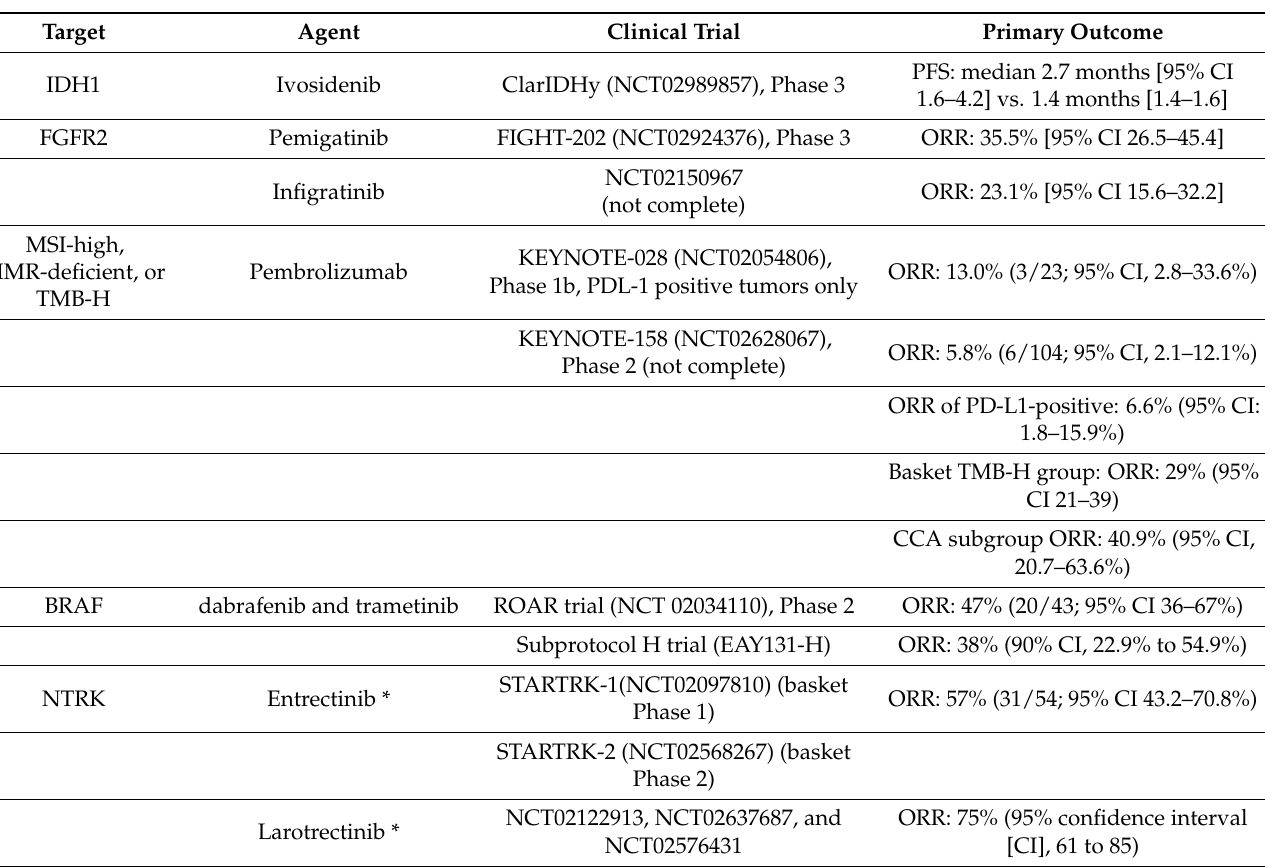
Table 1. Primary outcomes of completed clinical trials of targeted inhibition in iCCA. ORR: overall response rate. PFS: progression-free survival.